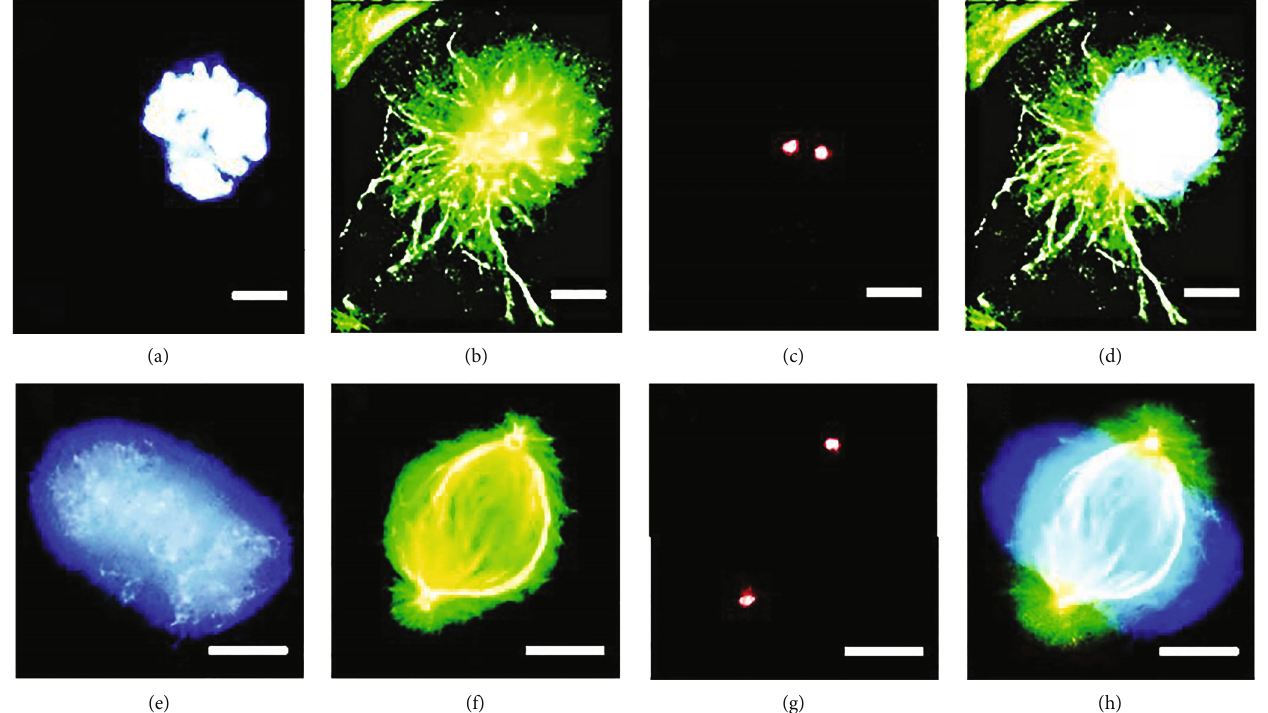
Figure 10: Vero cell metaphase analysis after 4 hours of treatment with Mix 300. (a – d) Aberrant metaphases and (e – h) control metaphase. Speci fi c chromatin labeling with Hoechst 33258 (a, e). Immunodetection of mitotic spindle microtubules with anti- α -tubulin (b, f). Immunodetection of centrosomes with anti- γ -tubulin (c, g). Superimposed images of the three channels (d, h). 5 μ